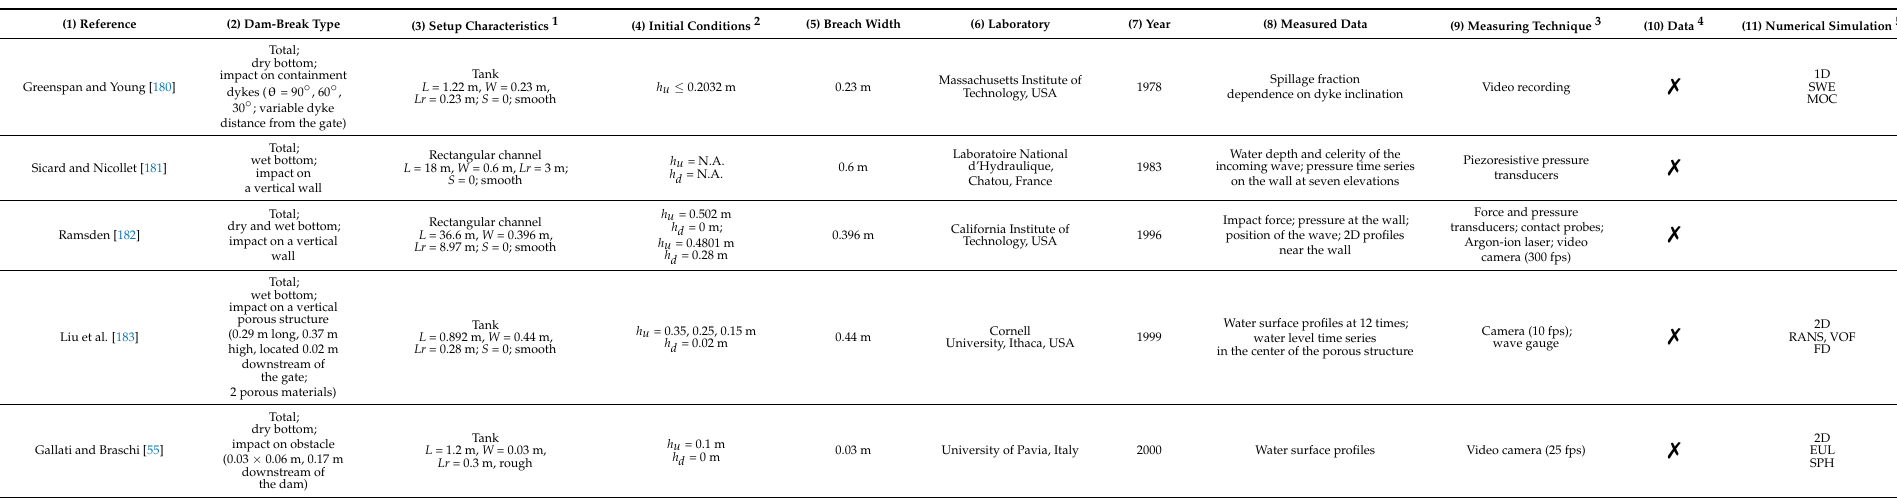
Table 3. Experimental investigations of the dam-break wave impact against obstacles.